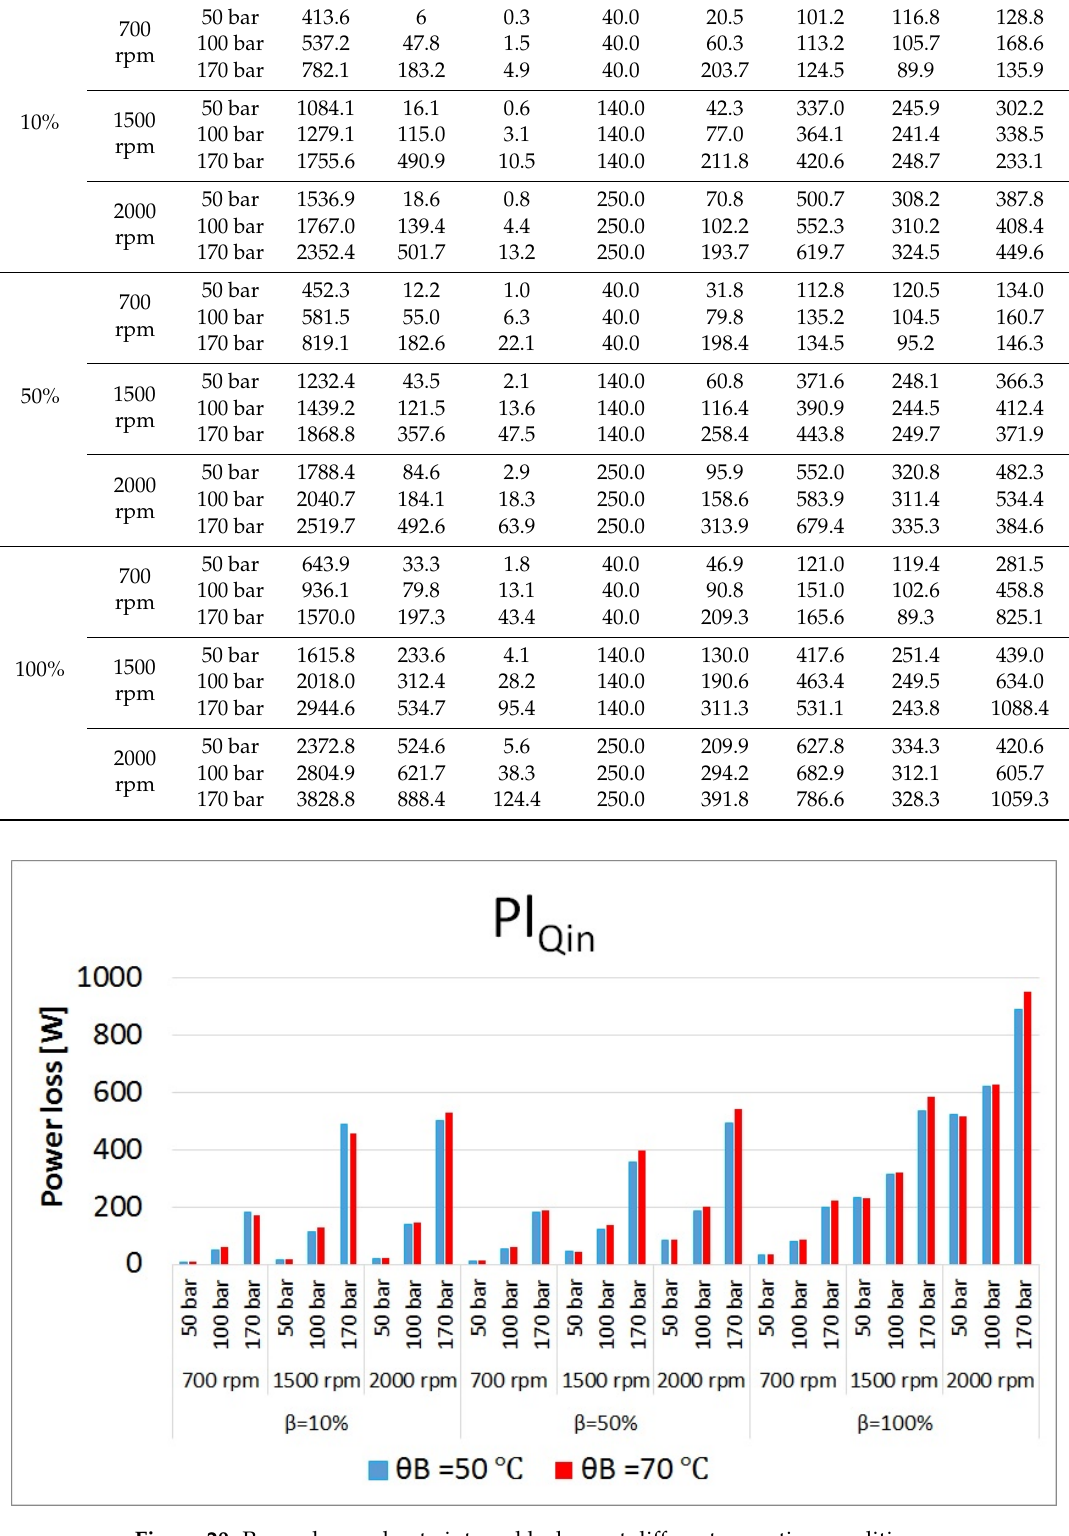
Figure 20. Power losses due to internal leakage at different operating conditions. Table 5. Distribution of power losses in the S-APP a 52 cc size; θ B = 50 °C.